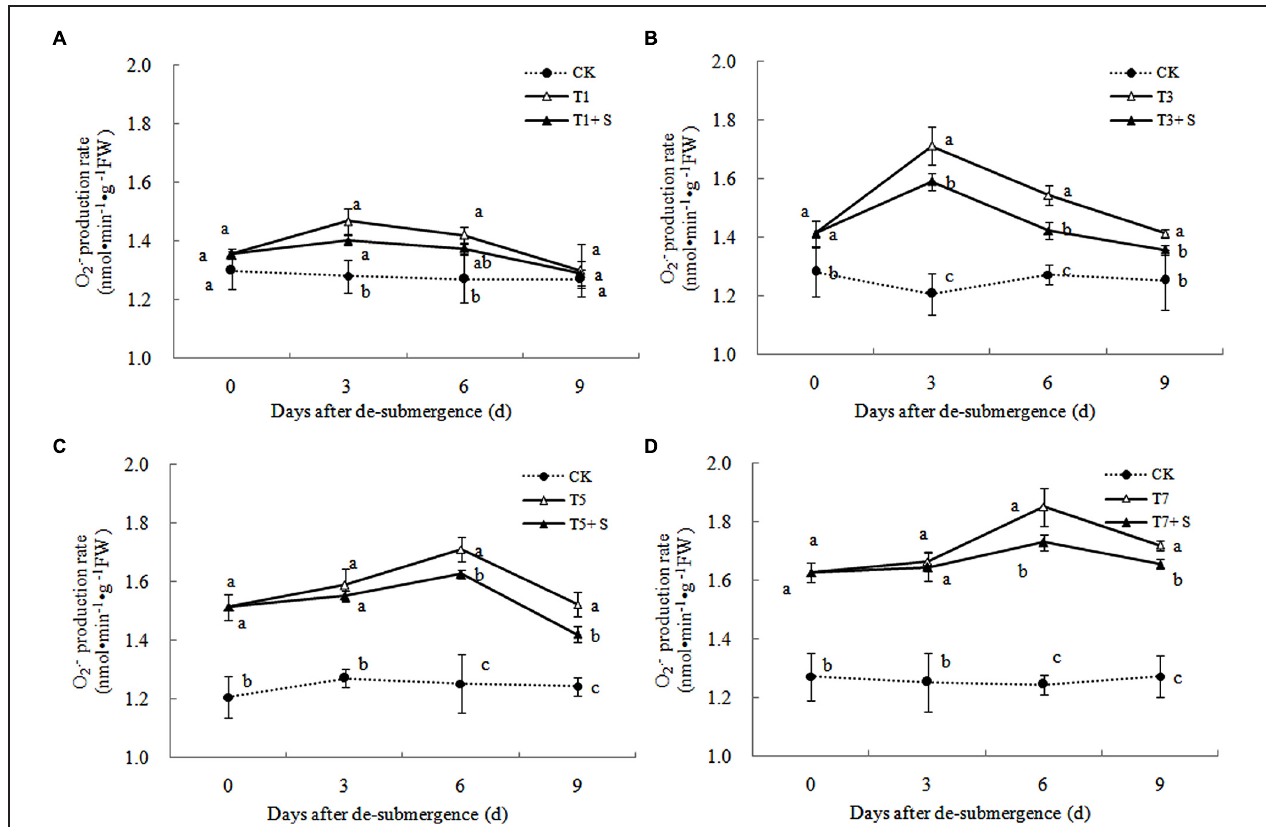
FIGURE 7 | Effects of Spd on O ·−